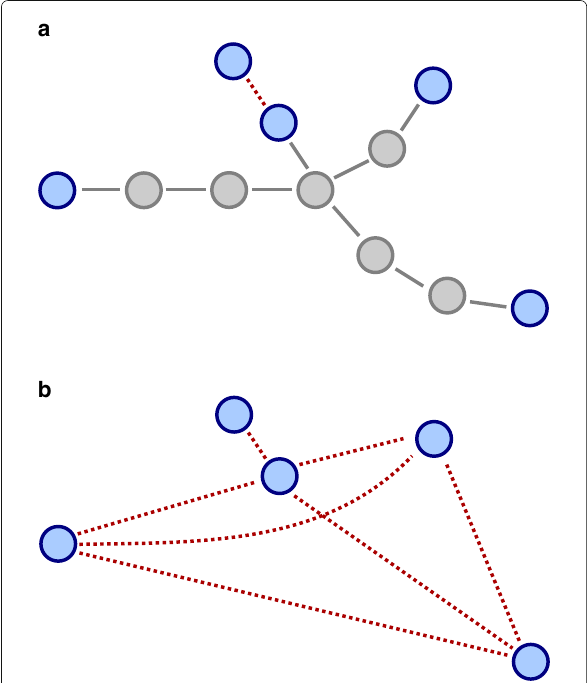
Fig. 4 Illustration of underlay/overlay interdependencies for multi-hop contacts. a Layer 2 topology b Actual DTN